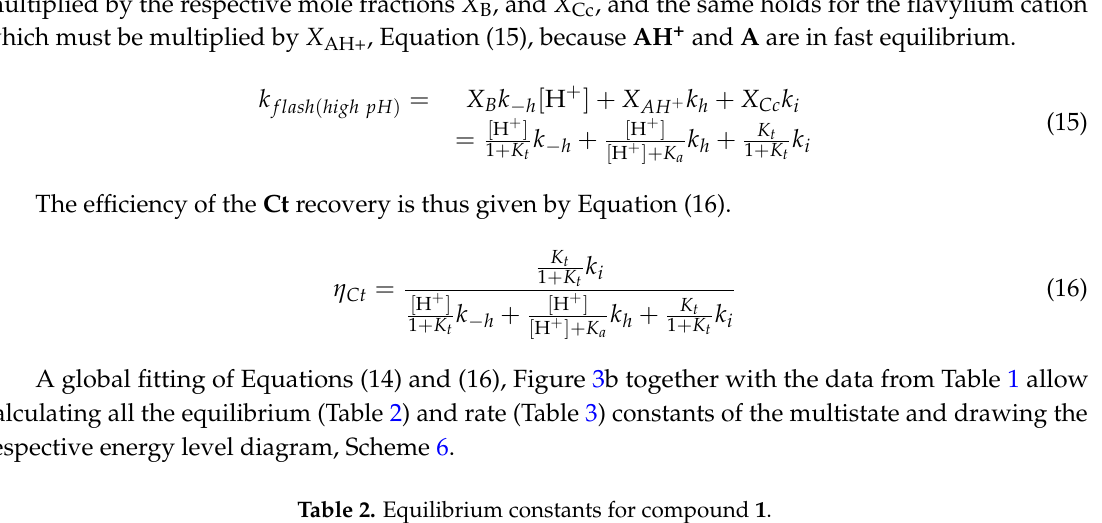
Table 2. Equilibrium constants for compound 1 .